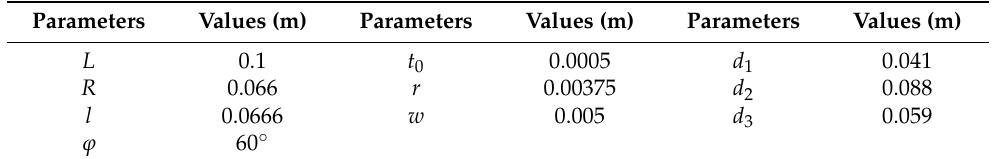
Table 2. Structural parameters of 4-4R compliant parallel pointing mechanism and loading position of F 1